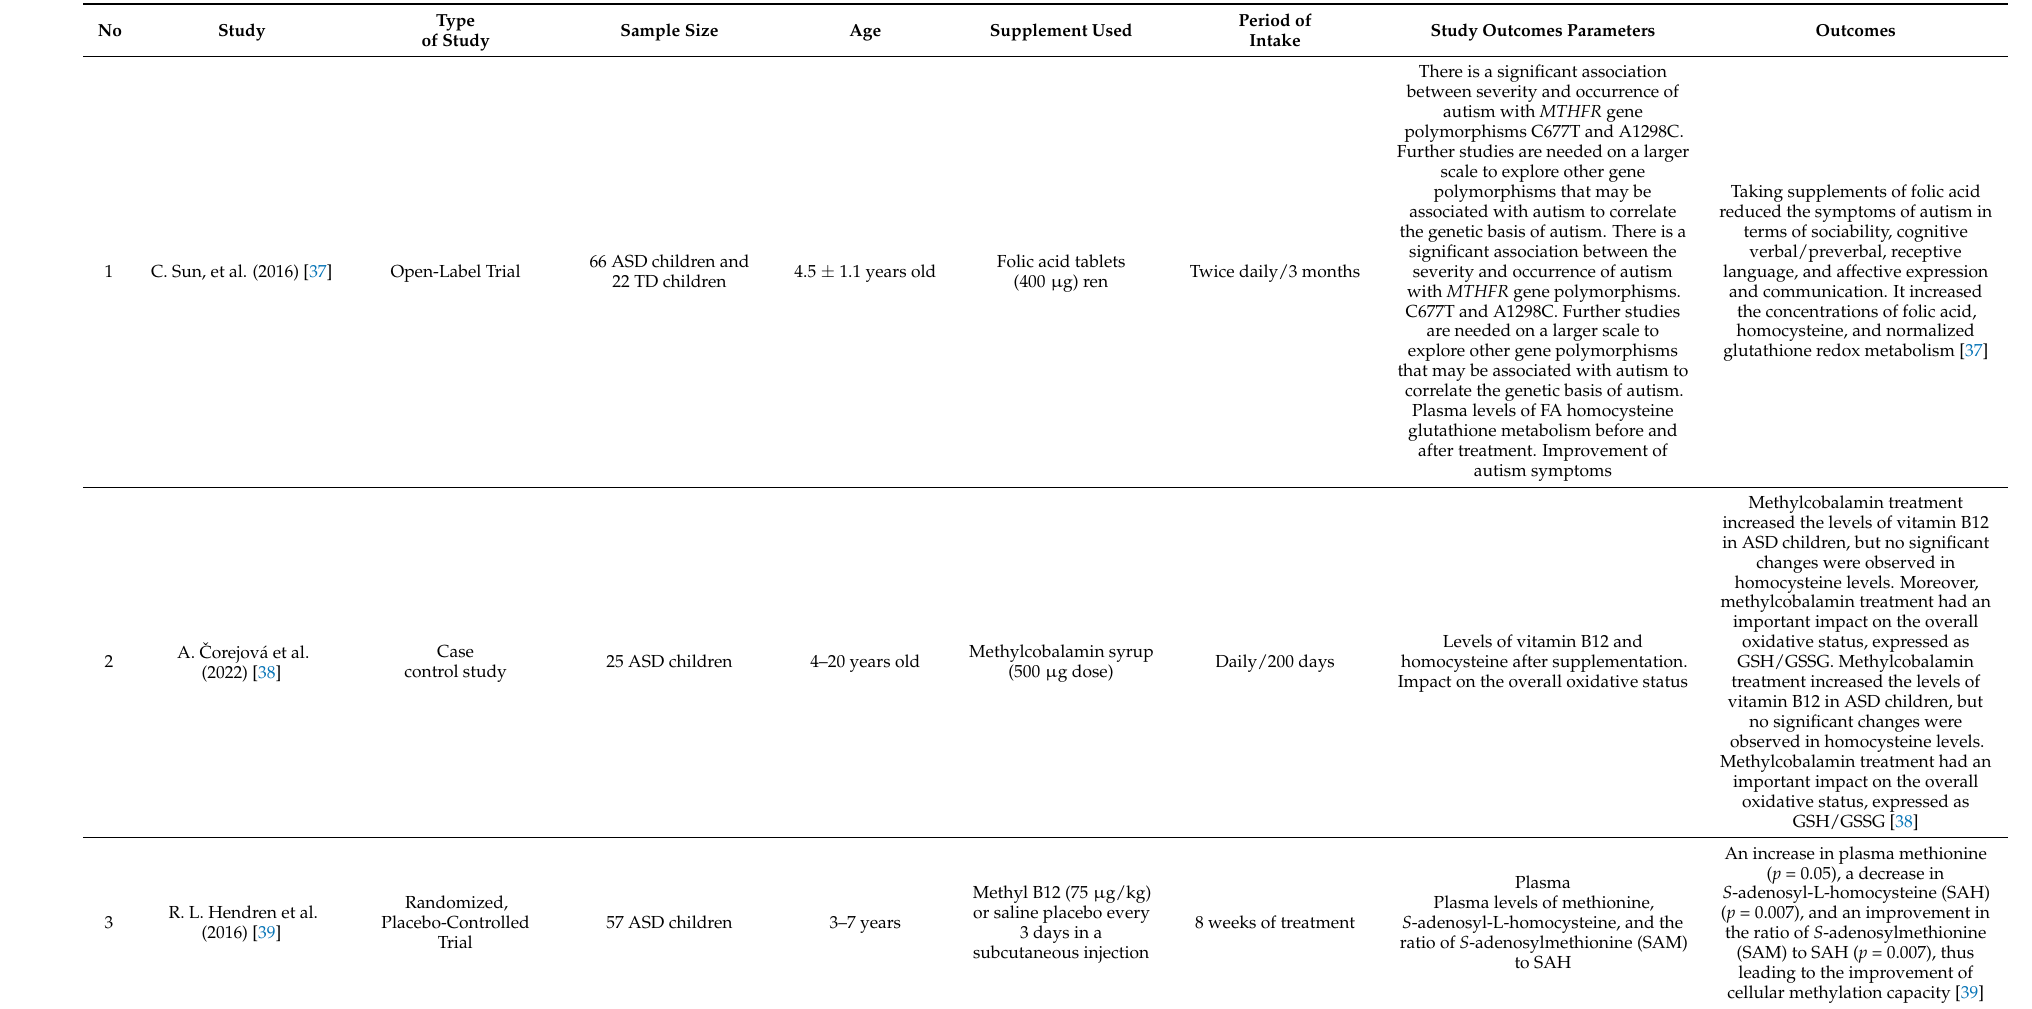
Table 4. Studies on the effect of folate and vitamin B12 supplementation in ASD